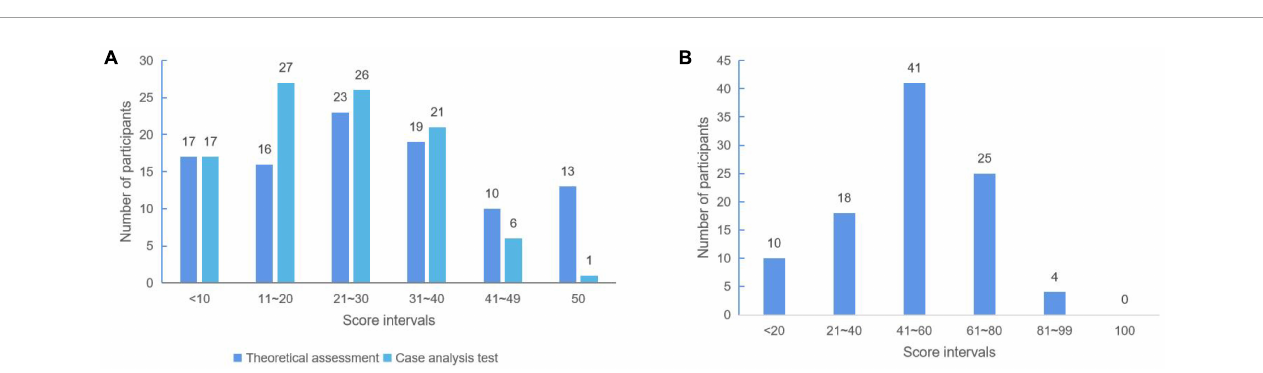
FIGURE2 The distribution of scores of students’ test questions. (A) Theoretical assessment and case analysis test score. (B) The total score of the test.